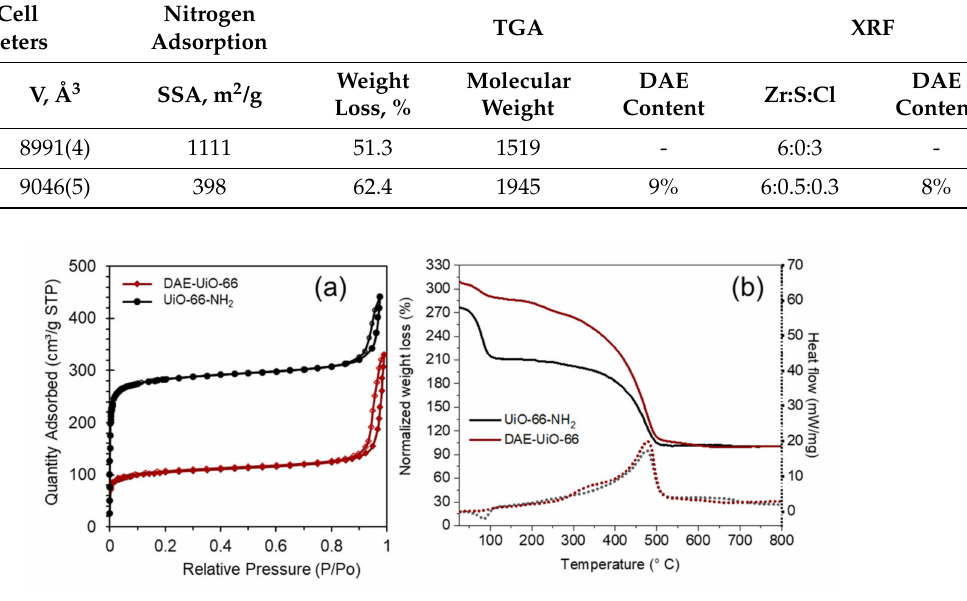
Figure 4. ( a ) Nitrogen adsorption–desorption isotherms of the UiO-66-NH2 (black) and DAE-UiO-66 (brown) samples. Filled markers designate isotherm adsorption branches; empty markers represent desorption branches. ( b ) TGA (solid lines) and DSC (dashed lines) curves of UiO-66-NH 2 (black) and DAE-UiO-66 (brown) samples. TGA curve was normalized according to solid residual (see details in Figure S5 in Supplementary